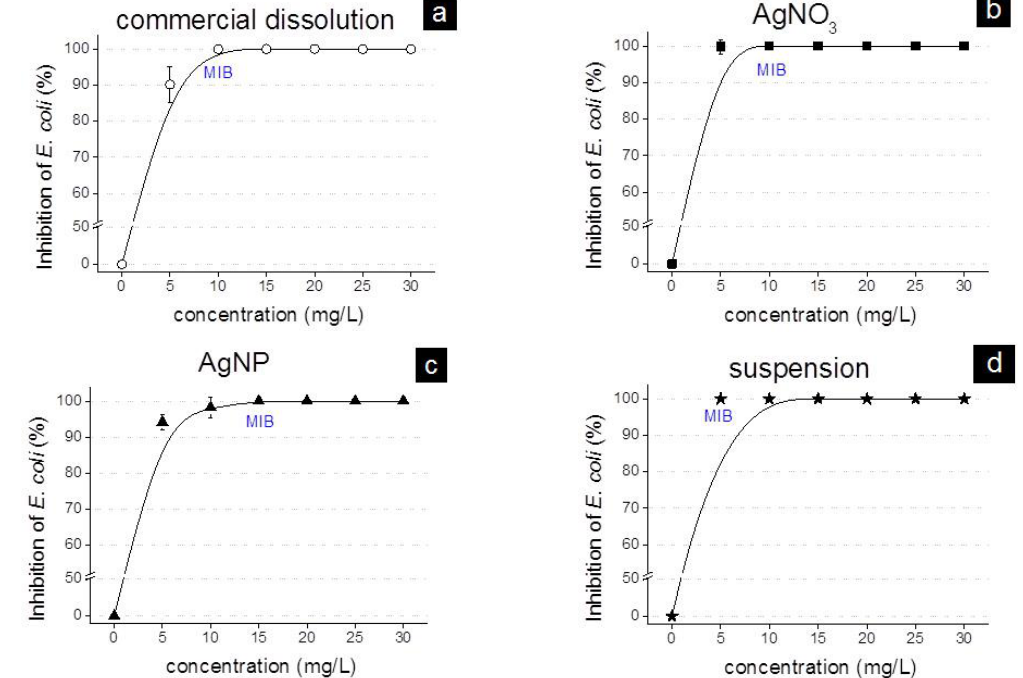
Fig. 9. Assays of inhibition (MIB) for different Ag solutions a) Commercial solution, b) AgNO sediment only d) Initial as prepared suspension, added to E. Coli ATCC 25992. All experiments were performed in duplicate on three separate occasions. Results represent the means ± standard deviations